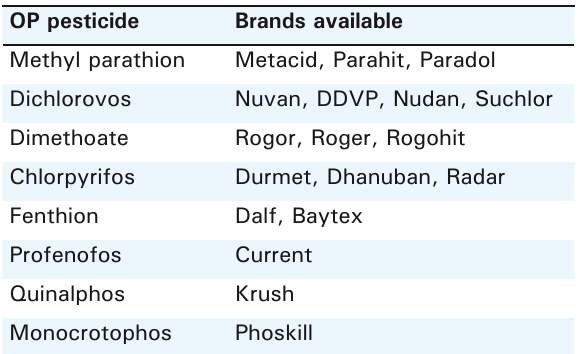
Table 2. Common OP pesticides with their brands available in